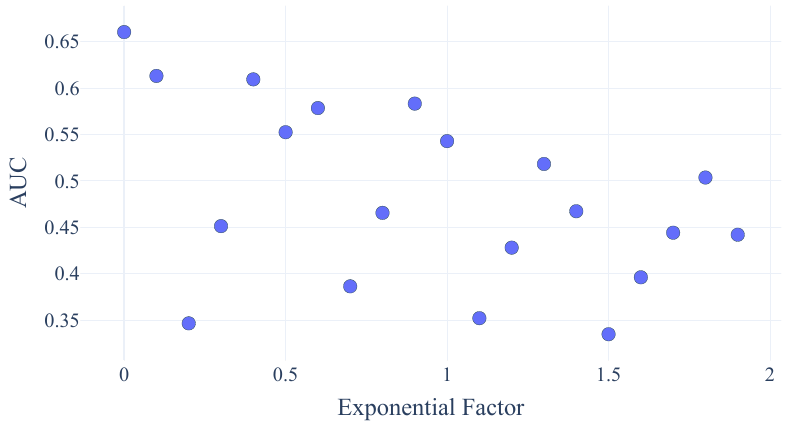
Figure 7. AUC receiver operating characteristic (ROC) values for a decreasing number of rising exponential factors.